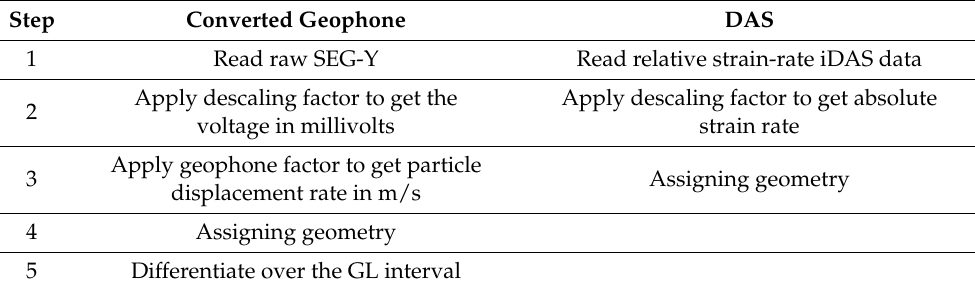
Table 2. Processing workflow for getting the absolute strain rate from geophone and DAS